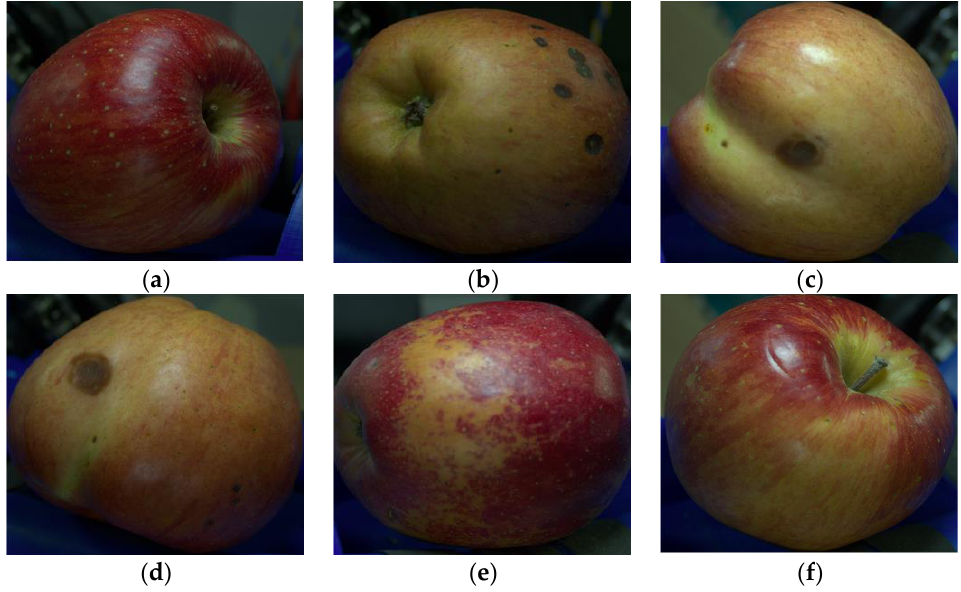
Figure 5. Normal and surface defects apple cases: ( a ) Normal; ( b ) Physiological disorder; ( c ) Mal- formation; ( d ) Pest; ( e ) Russeting; ( f ) Scratch. mation; ( d ) Pest; ( e ) Russeting; ( f )